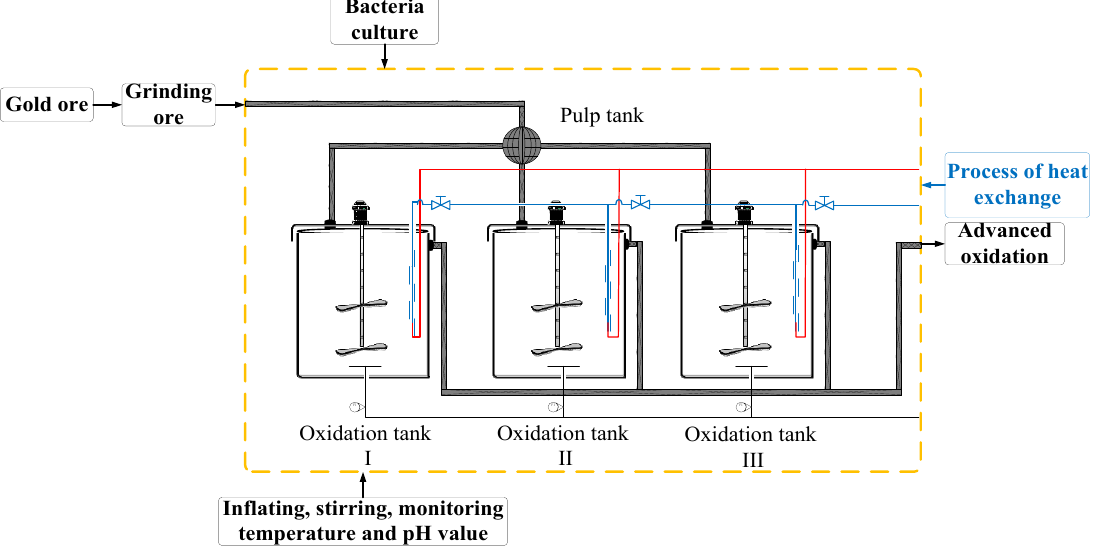
Figure 1. Biological oxidation pretreatment process.